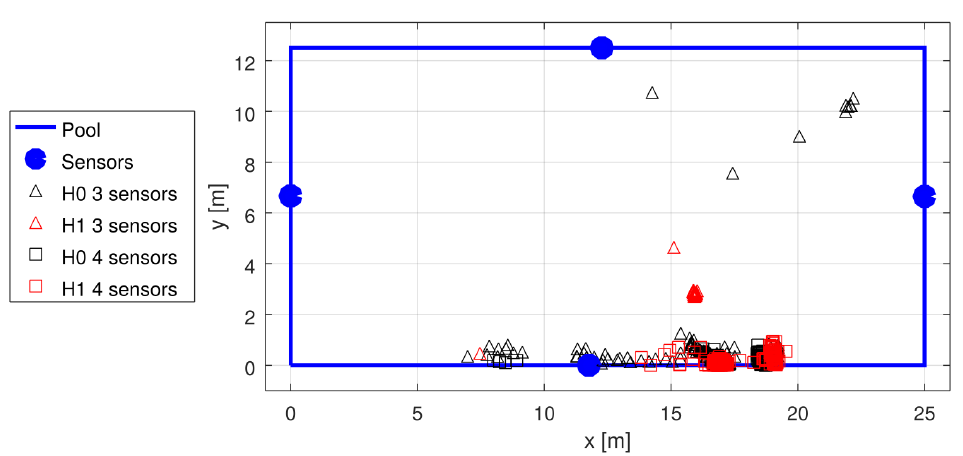
Figure 15. Localization results in sport pool test 1; the transmitter was moved along the pool side. A number of solutions with three sensors were accepted, but they were obviously